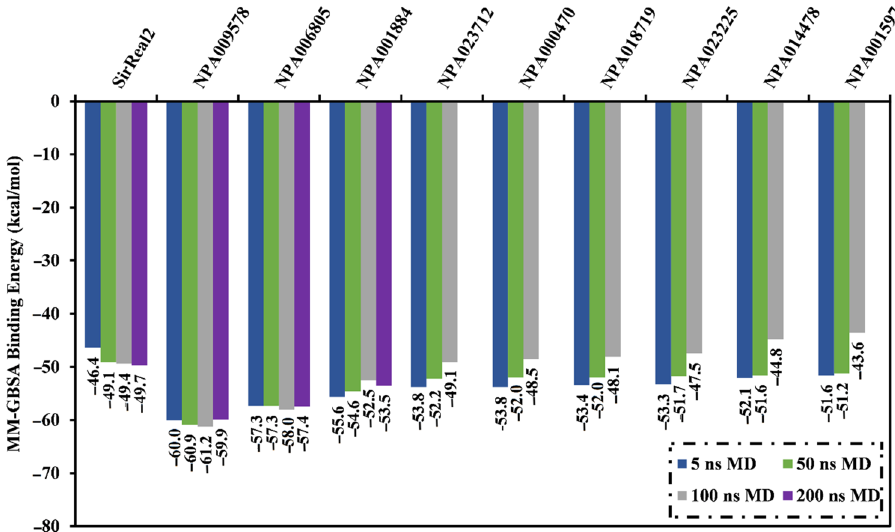
Figure 5. Average binding energies for the SirReal2 inhibitor and the identified potent NPAtlas compounds in complex with SIRT2 protein over 5 ns, 50 ns, 100 ns, and 200 ns MD simulations.